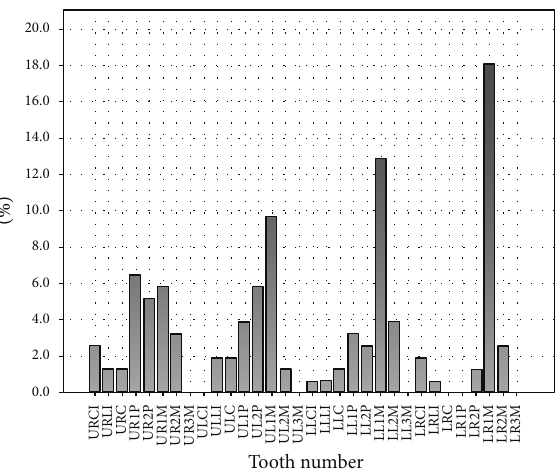
Figure 8: Percentage of underfill in individual teeth.